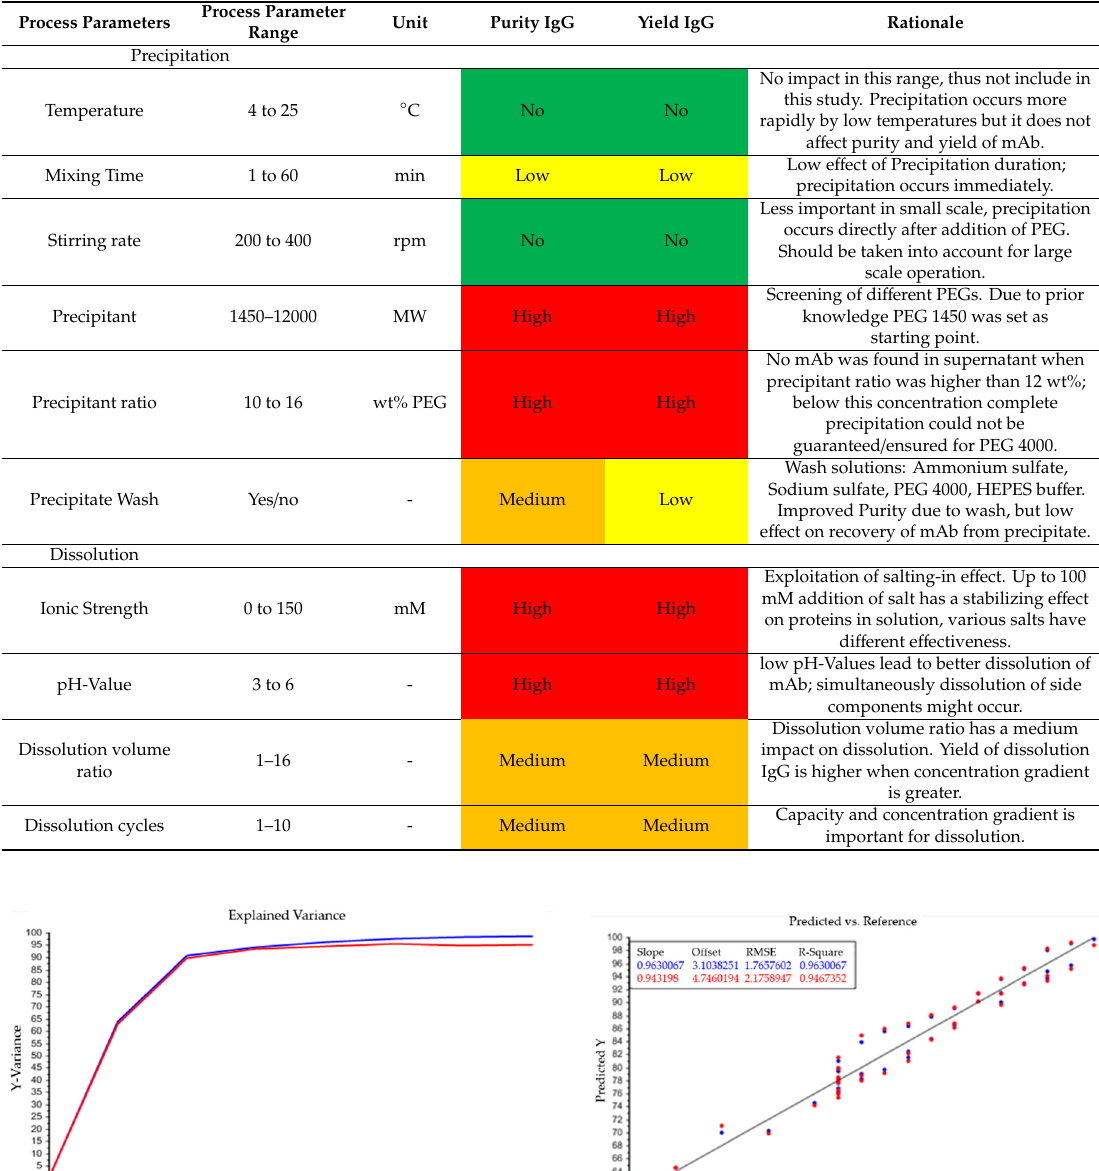
Table A3. Results of the conducted DoE and evaluation of e ff ects on product yield and purity.